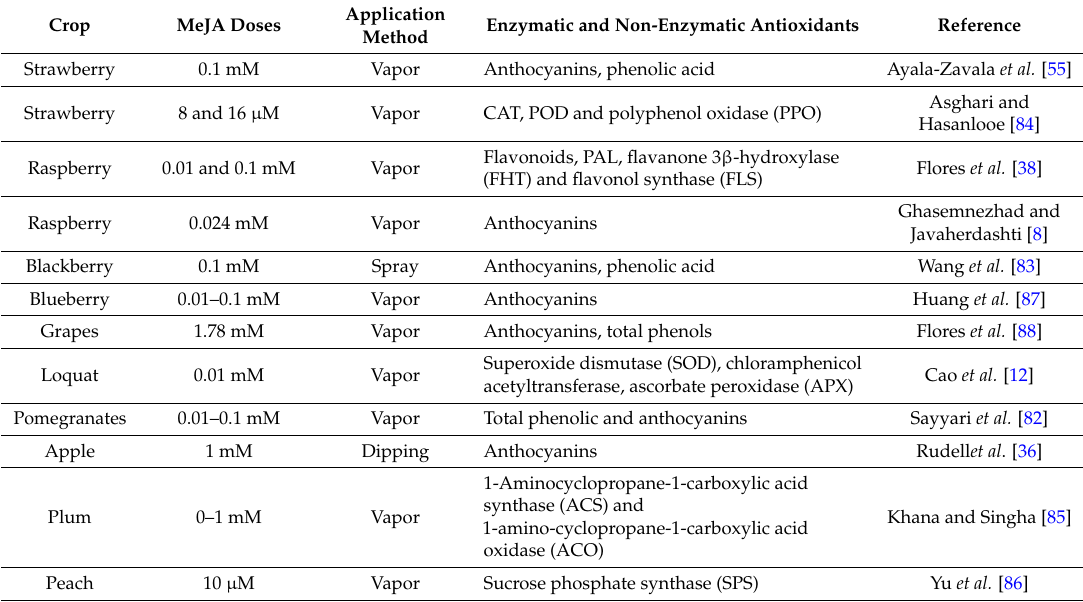
Table 2. Effect of post-harvest MeJA applications on the increase of antioxidant activity in fruits.